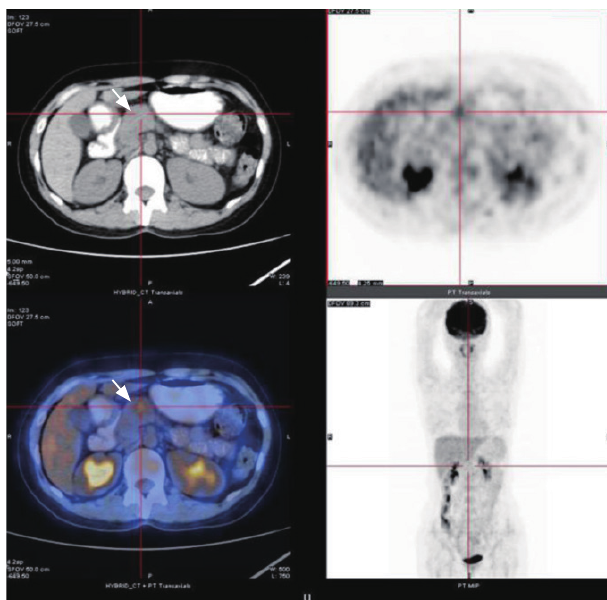
Figure 3 The 18F-fluorodeoxyglucose (FDG) positron emission tomography/computed tomography images revealed medium-level FDG uptake in the pancreatic lesion (arrows).